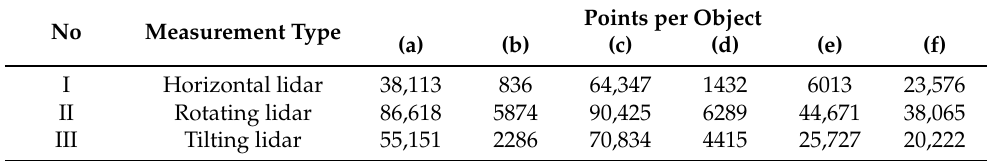
Table 3. Comparison of the number of points per